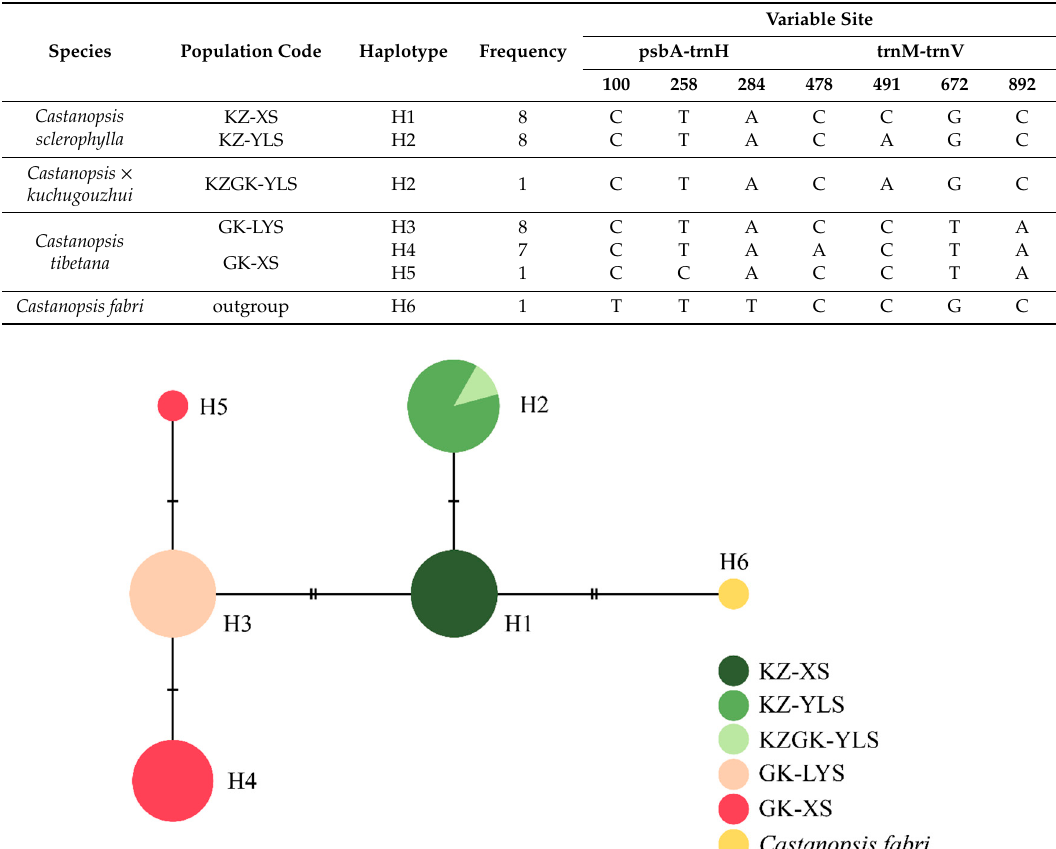
Table 2. DNA sequence variation and chloroplast haplotypes revealed in this study.